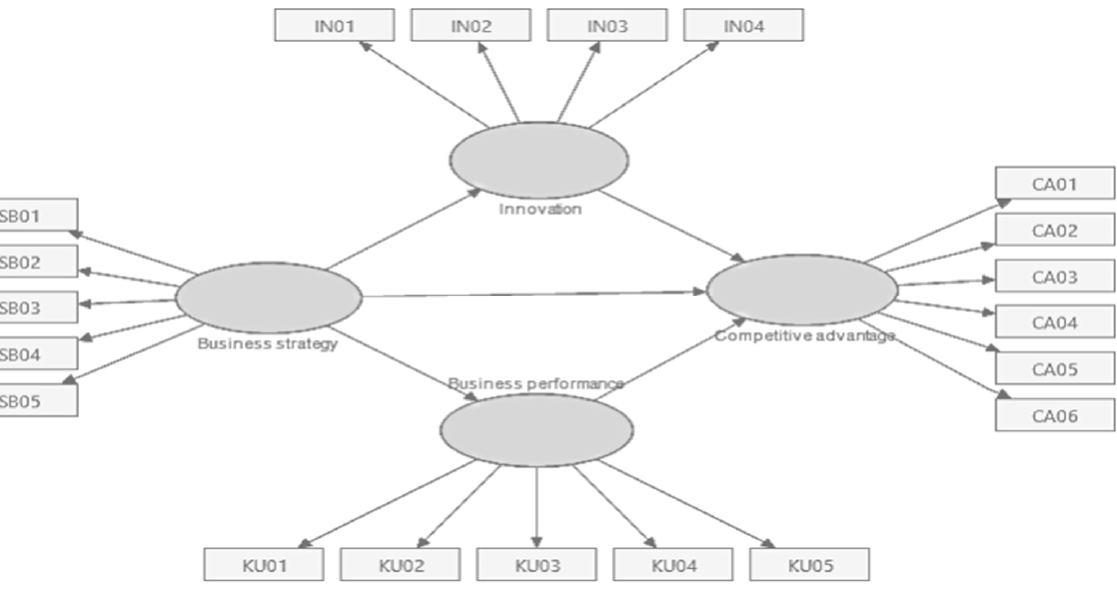
Figure 1. Conceptual framework.